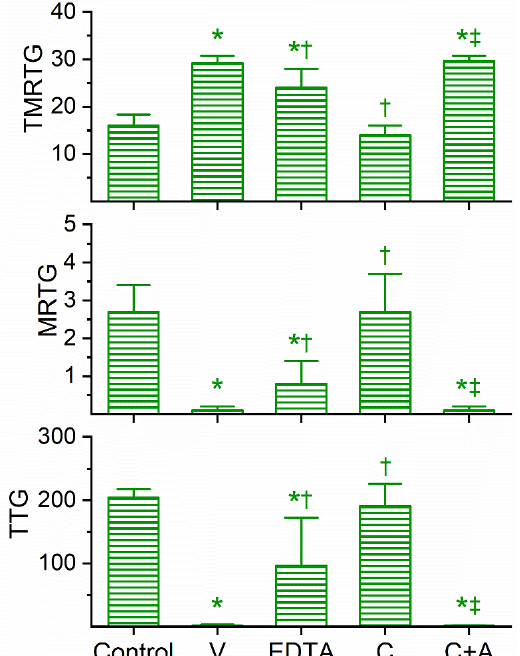
Figure 4. Anticoagulant activity of D. viridis venom in human plasma and e ff ects of EDTA and CORM-2 on venom activity. Data are presented as mean ± SD. TMRTG = minutes; MRTG = dynes / cm 2 / sec; TTG = dynes / cm 2 . Control = No additives; V = 4 µ g / mL final venom concentration; EDTA = 4 µ g / mL venom after being exposed to 5 mM EDTA; C = 4 µ g / mL venom after being exposed to 100 µ M CORM-2 in PBS; C + A = 4 µ g / mL venom after being exposed to 100 µ M CORM-2 in 5% human albumin. * p < 0.05 vs. control; † p < 0.05 vs. V; ‡ p < 0.05 vs. C.